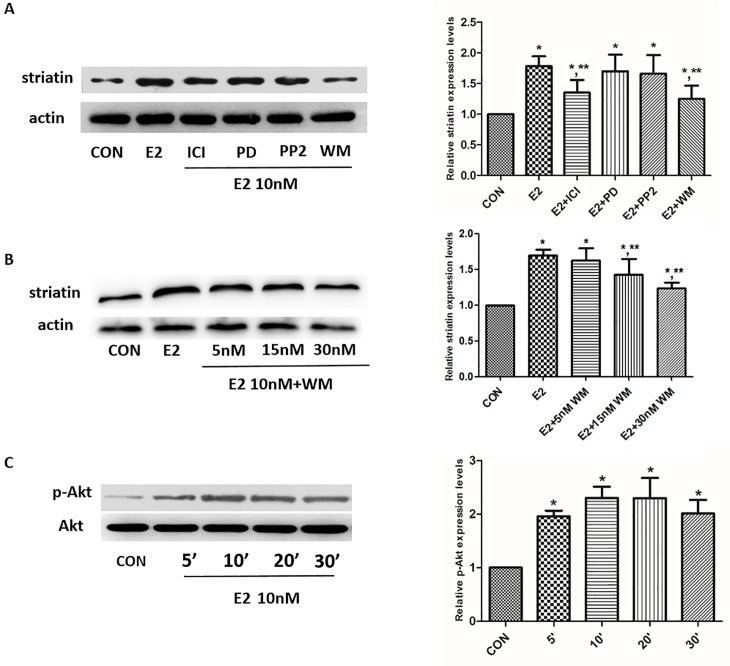
E2 upregulated striatin expression via Akt pathway in HUVECs.(A) HUVECs were treated with E2 (10nM) for 24h, in the presence or absence of the pure ER antagonist ICI 182,780 (ICI– 1mM), of the MEK inhibitor PD98059 (PD– 5mM), of the PI3K inhibitor wortmannin (WM– 30nM) or of the c-Src kinase inhibitor, PP2 (10mM). Striatin densitometry values were adjusted to actin intensity, then normalized to expression from the control sample. Expression in CON group was normalized to 1, *p<0.01 versus CON, **p<0.01 versus E2. Bars represent SD, n = 4. (B) HUVECs were treated with E2 (10nM) for 24h, in the presence of the PI3K inhibitor wortmannin (WM –5- 30nM). Striatin densitometry values were adjusted to actin intensity, then normalized to expression from the control sample. Expression in CON group was normalized to 1, *p<0.01 versus CON, **p<0.01 versus E2. Bars represent SD, n = 4. (C) HUVECs were treated with E2 (10nM) for the indicated time and wild-type Akt or Ser 473-phosphorylated Akt (p-Akt) were detected by western blot. p-Akt densitometry values were adjusted to Akt intensity, then normalized to expression from the control sample. Expression in CON group was normalized to 1, *p<0.01 versus CON. Bars represent SD, n = 4.